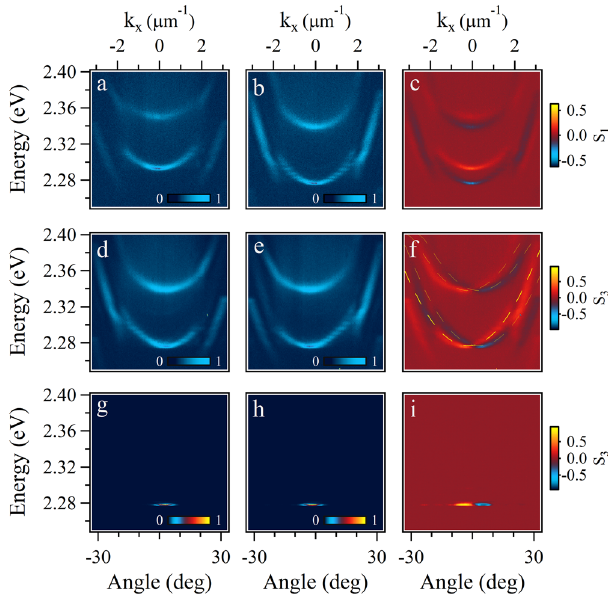
Fig. 3 Rashba-Dresselhaus effect on polariton dispersion. a Horizontally and ( b ) vertically linearly polarized dispersion below the threshold at 2 V. c Linearly polarized dispersion calculated from ( a , b ). d Left- and ( e ) right- hand circularly polarized dispersion below the threshold at 4.5 V. g Left- and ( h ) right-circularly polarized dispersion above the threshold at 4.5 V. f , i Circularly polarized dispersion corresponding to ( d , e ), and ( g , h ), respectively. The fi tted curves in ( f ) are calculated by the Hamiltonian (1) with parameters: E x = 2.406 eV, E p = 2.352 (2.284) eV for the upper (lower) set, m = 3.5 × 10 − 6 m e ( m e is the free electron mass), ξ = 5 meV, and β 0 = β 1 =